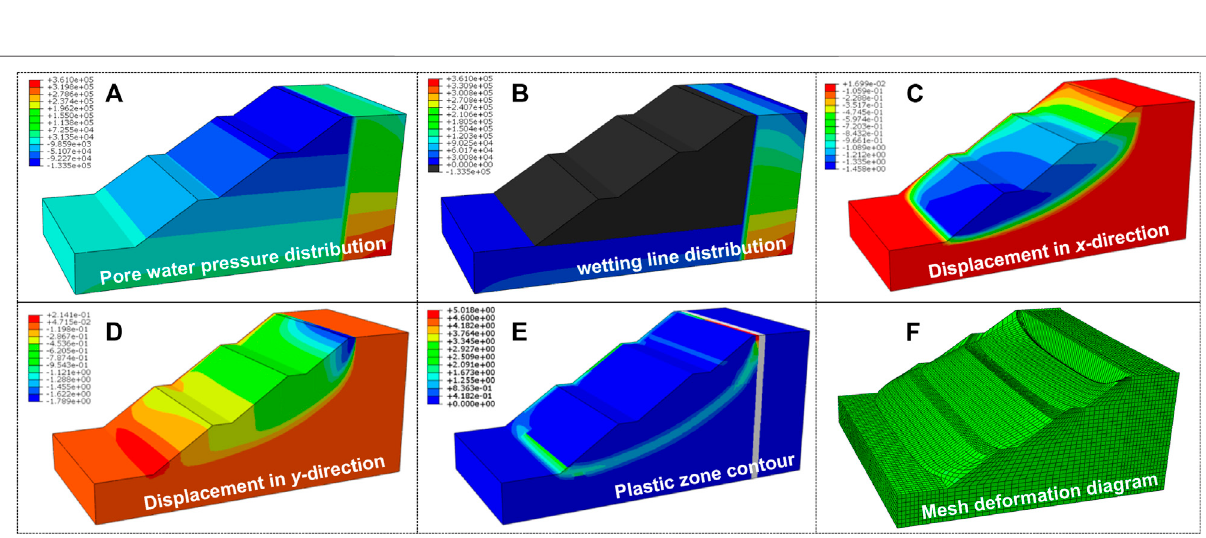
FIGURE 2 | (A) Pore water pressure distribution; (B) wetting line distribution; (C) displacement in x -direction; (D) displacement in y -direction; (E) plastic zone contour; and (F) mesh deformation diagram of the slope at the initial condition.